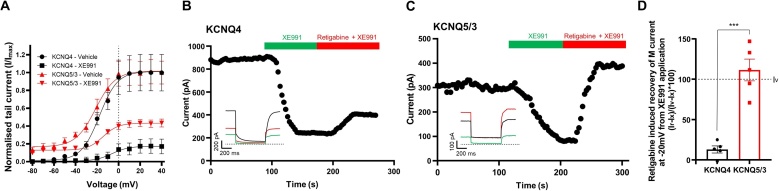
XE991 elicits a partial blockade of current through Kv7.5/Kv7.3 heteromeric channels that can be fully recovered by retigabine. (A) Current voltage relationship of Kv7.4 (n = 8) and Kv7.5/3 (n = 10) channels prior to and post XE991 (10 μM) treatment. (B,C) Representative voltage clamp recordings at −20 mV showing effects of XE991 (10 μM) and retigabine (10 μM; applied in the presence of XE991) on Kv7.4 (B) or Kv7.5/3) (C) channel currents. (D) Retigabine induced recovery (Ir) of Kv7 (M) current at −20 mV after XE991 application (Ix) expressed as a percentage of the control (vehicle) current (Iv). Recovery calculated as (Ir-Ix)/(Iv-Ix). Data are presented as mean ± S.E.M.; ***P < 0.001 (independent measures two-tailed t-test).